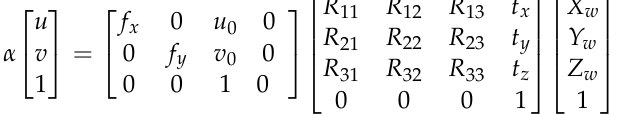
Figure 2. Coordinate system conversion.